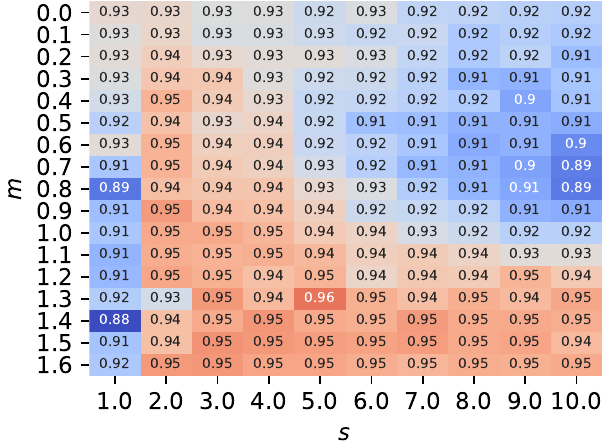
Figure 12. The F 1 scores of AAMSoftmax + OpenMAX when trained by 21 authorized devices with different s and m